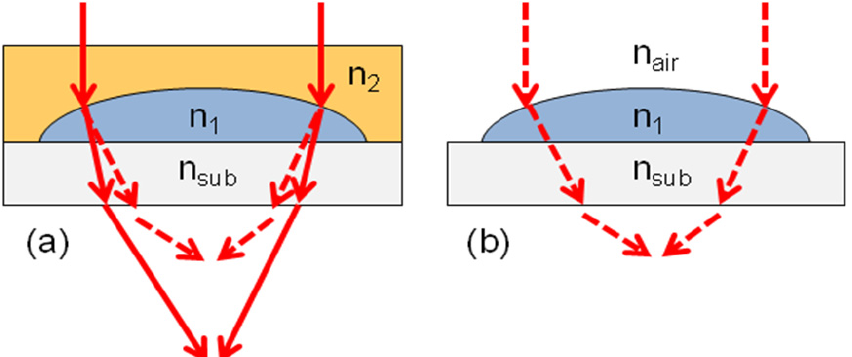
Figure 1. (a) Light propagation in a microlens by (a) our new method (solid lines) and (b) traditional thermal method (dashed